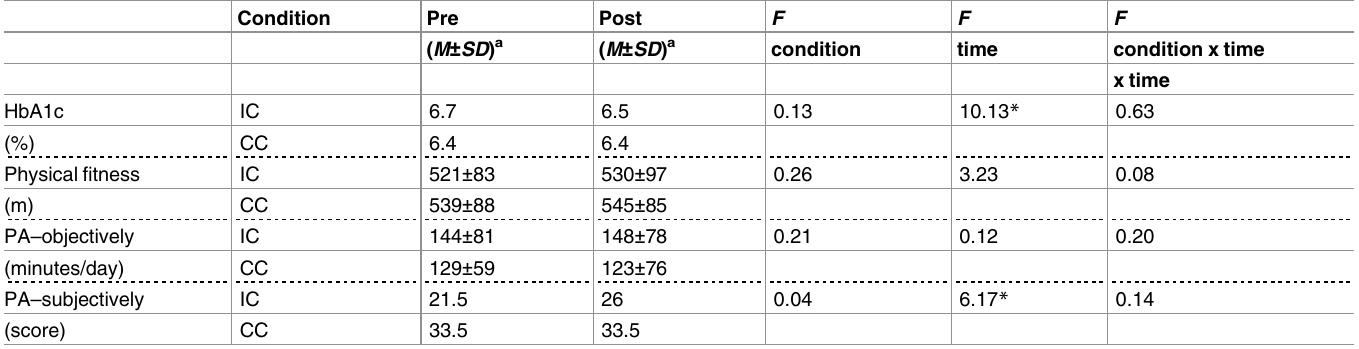
Table 3. Short-term